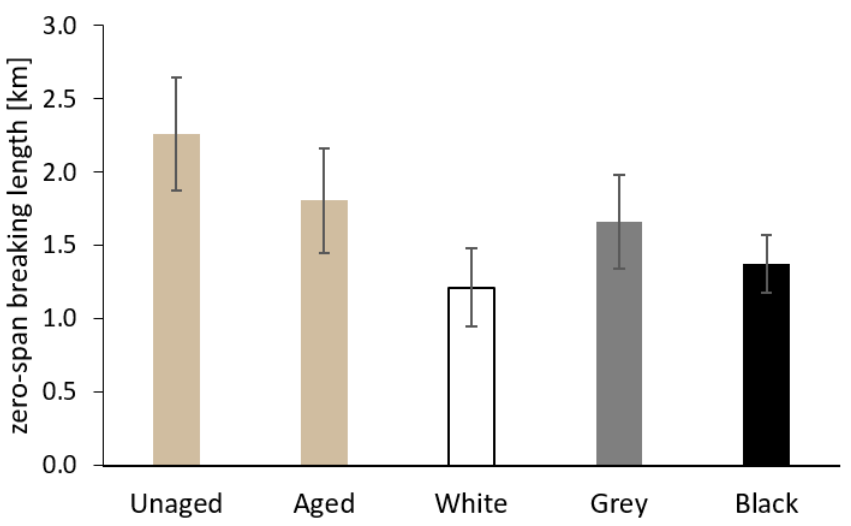
Figure 14. The zero-span breaking length of wood-pulp paper before aging (Unaged), after artificial aging without contact with PE foam (Aged), and in contact with the tested PE foams.